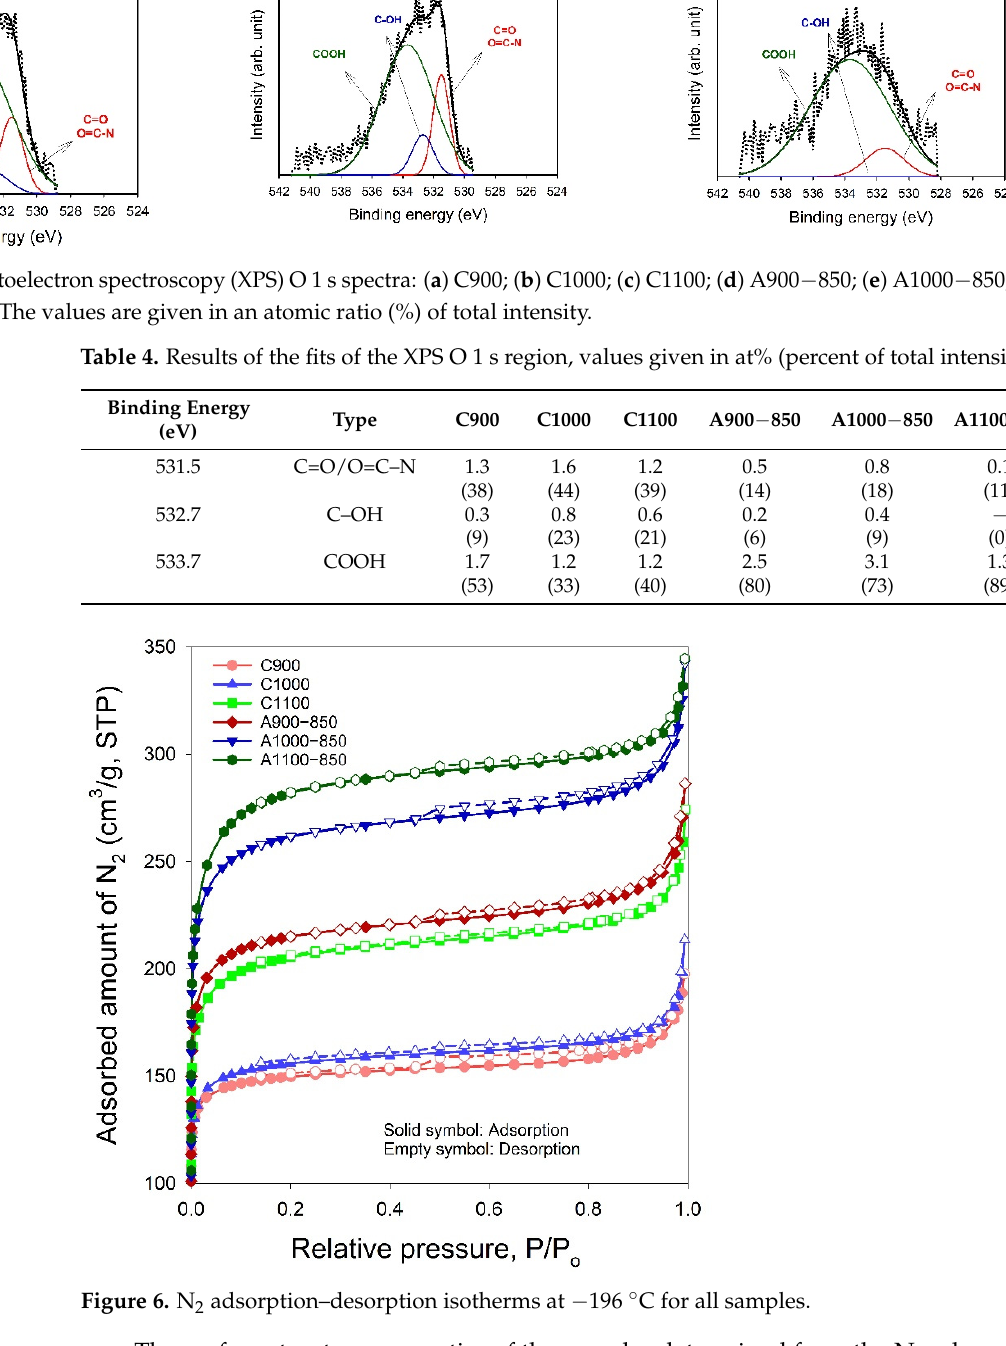
Table 4. Results of the fits of the XPS O 1 s region, values given in at% (percent of total intensity).